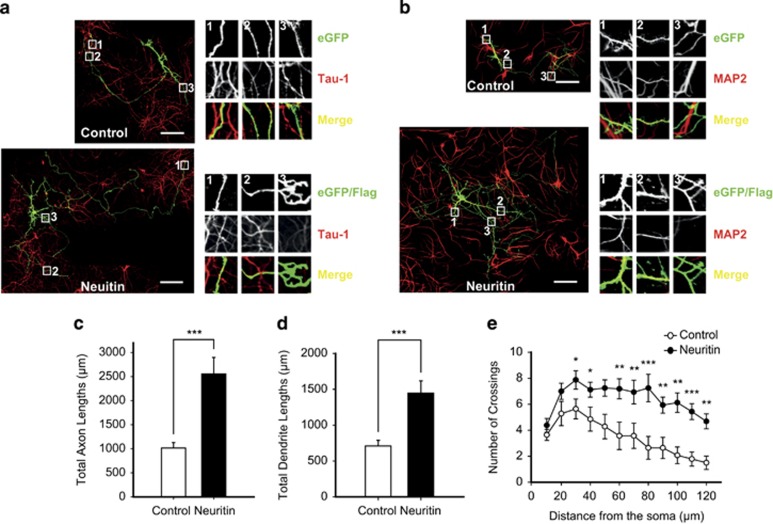
Neuritin expression increases neurite outgrowth. (a and b) Confocal images of either control vector- or neuritin-expressing neurons that were co-immunostained with eGFP alone or eGFP/Flag (green), Tau-1 (a, red) or MAP2 (b, red). Scale bar, 100 nm. Insets are × 6.9 magnified views of designated regions. Total axonal length (c: Control, 1017.13±112.96 μm, n=19 neurons versus Neuritin, 2555.57±341.08 μm, n=26 neurons) and dendritic length (d: Control, 709.35±78.79 μm, n=23 neurons versus Neuritin, 1446.69±171.17 μm, n=30 neurons) of control- and neuritin-expressing neurons are depicted. (e) Sholl analyses for neurites visualized with Flag staining. Neuritin slowed down the decrement rate of crossing numbers (at 30 μm: Control, 5.64±0.76 versus Neuritin, 7.88±0.71, *P=0.0402; at 40 μm: 4.86±0.93 versus 7.13±0.58, *P=0.0415; at 60 μm: 3.57±1.06 versus 7.19±0.77, **P=0.0011; at 70 μm: 3.57±0.97 versus 6.94±0.91, **P=0.0053; at 80 μm: 2.64±0.88 versus 4.25±1.06, ***P=0.0004; at 90 μm: 2.64±0.82 versus 5.94±0.62, **P=0.0018; at 100 μm: 2.27±0.63 versus 5.71±0.68, **P=0.0018; at 110 μm: 1.79±0.55 versus 5.44±0.61, ***P=0.0009; at 120 μm: 1.91±0.51 versus 4.69±0.58, **P=0.0012). Statistical significance is expressed as *P<0.05; **P<0.01; ***P<0.001